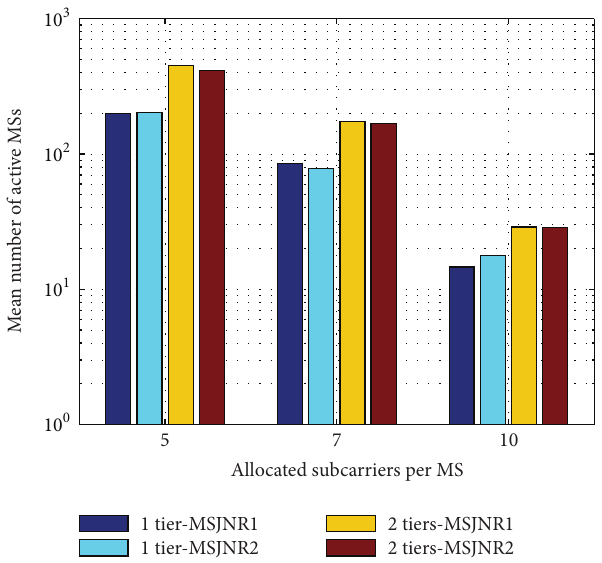
Figure 9: Mean number of MSs for the MSJNR1 and MSJNR2